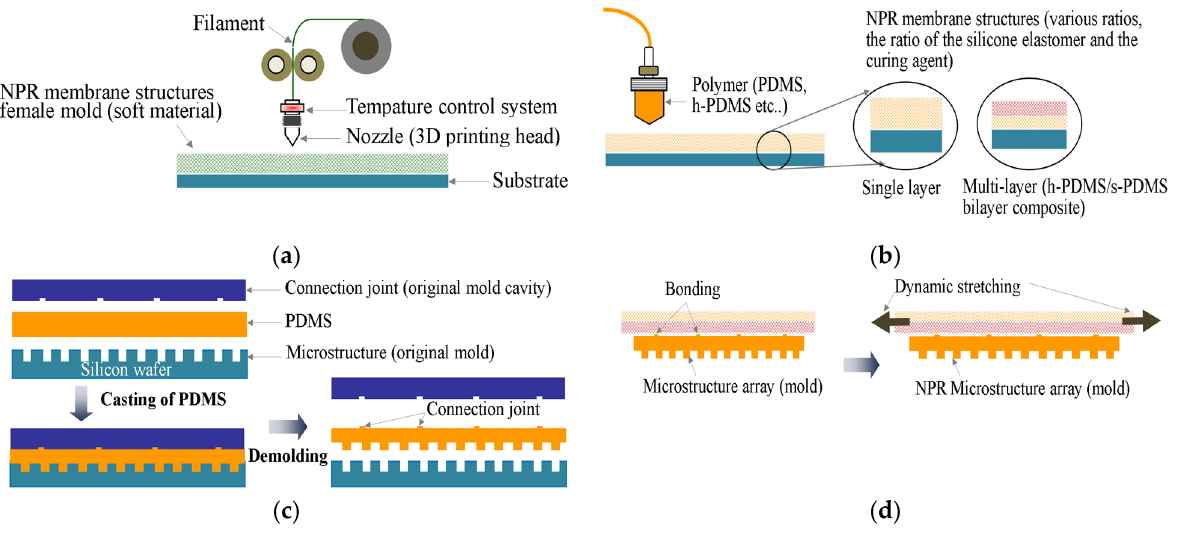
Figure 4. The procedure to fabricate uniaxial parallel flexible NPR microstructure molds was as follows: ( a ) the complementary female molds of NPR structures were fabricated by high-precision 3D printing technology; ( b ) PDMS or h-PDMS/s-PDMS bilayer composites were accurately injected into the complementary cavity of NPR membrane structures to cure and form NPR structures; ( c ) PDMS microstructure molds with fixed bonding points at the top and microstructural arrays at the bottom were prepared; and ( d ) the fixed connections at the top of PDMS microstructure molds were bonded to NPR structures to obtain the point-bonded NPR PDMS microstructure molds after curing.